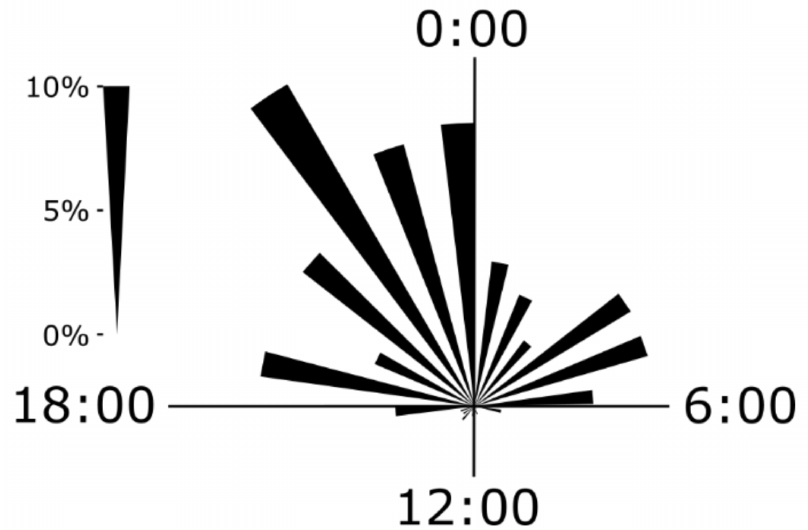
Figure 2. Circadian repartition of eels (N = 960) swimming toward the lagoon counted over the 15 days for which videos were analysed from 00:00 to midnight. For each hour (black triangle), the percentage was calculated as the number of eels counted during this hour divided by the total number of counts in 24